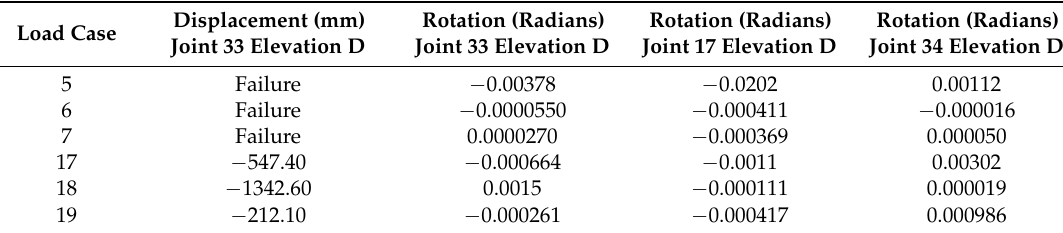
Comparison between displacements and rotations when interior column D2 is notionally